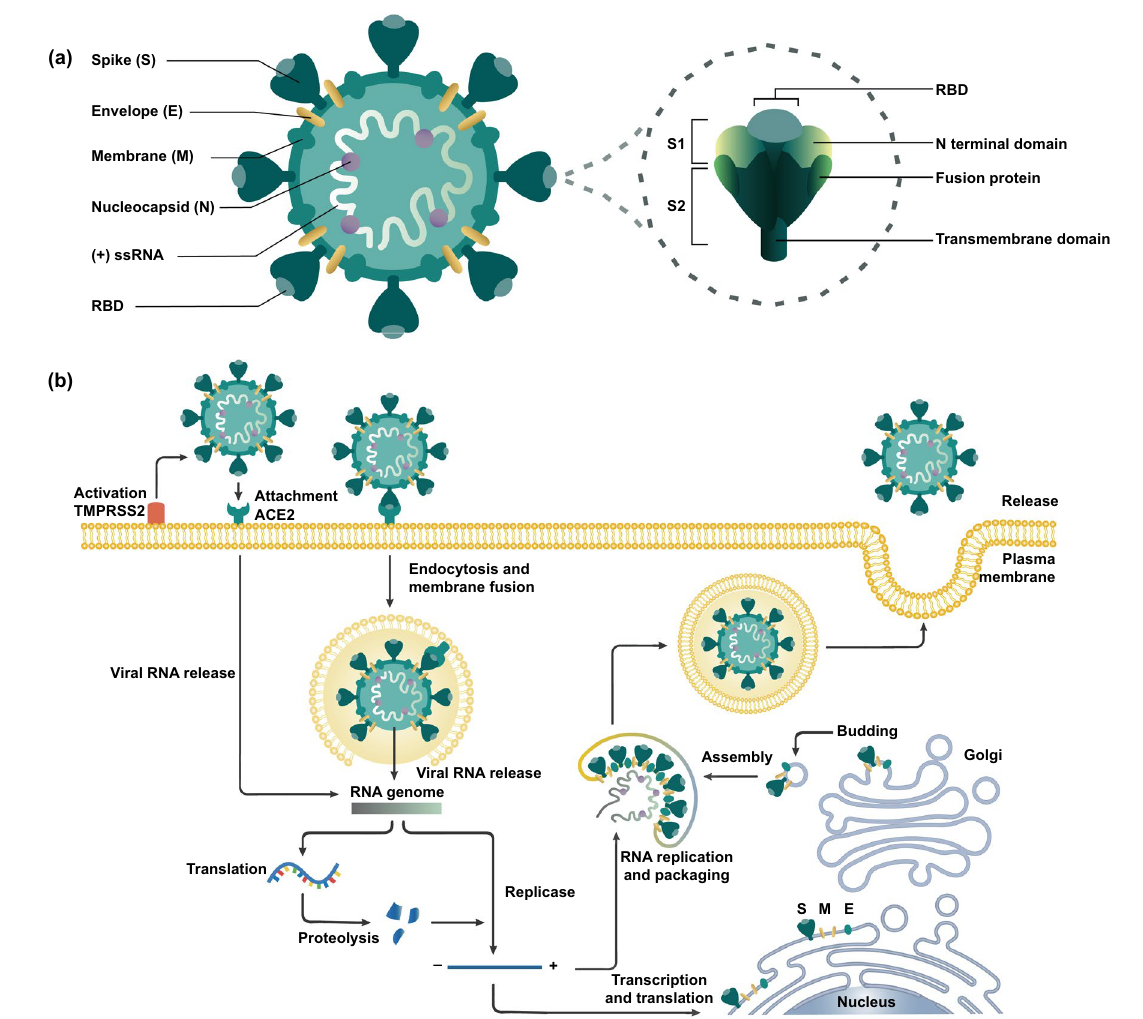
Fig. 2 a Schematic representation of SARS‑CoV‑2 and spike glycoprotein main structural features. b The viral replication cycle initiates by the activation of the serine protease TMPRSS2 and angiotensin‑converting enzyme 2 (ACE2)